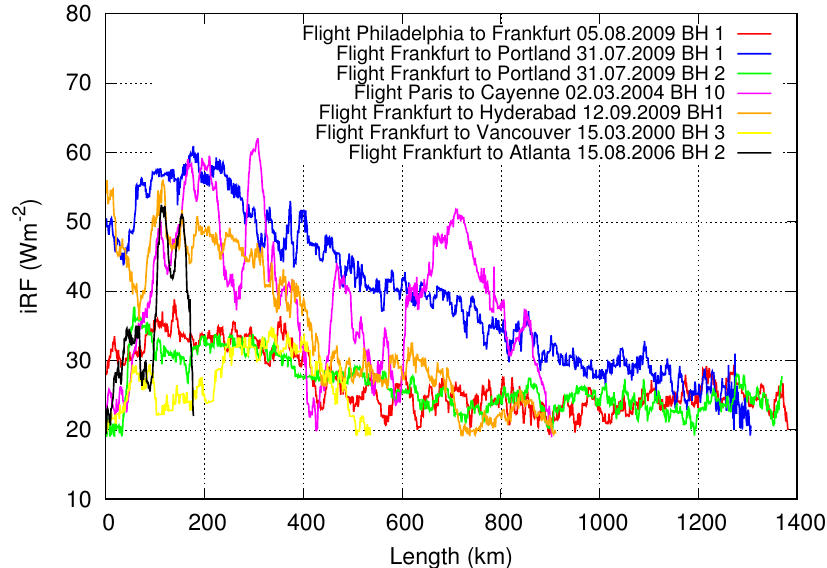
Figure 9. Time series of iRF values in a number of situations with consecutive iRF ≥ 19Wm − 2 that occurred on the flights indicated in the